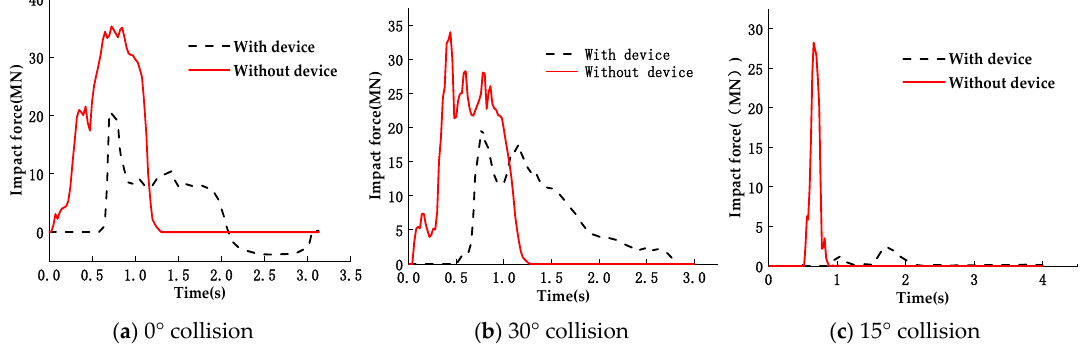
Figure 35. Time history curve of impact force of piers under different collision angles.